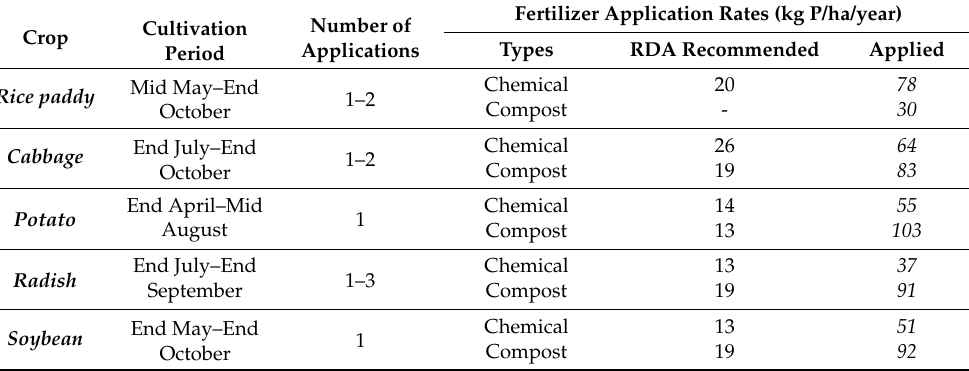
Table 3. Local agricultural practices for the five most common crops accounting for ~72% of the total agricultural area in the Haean watershed